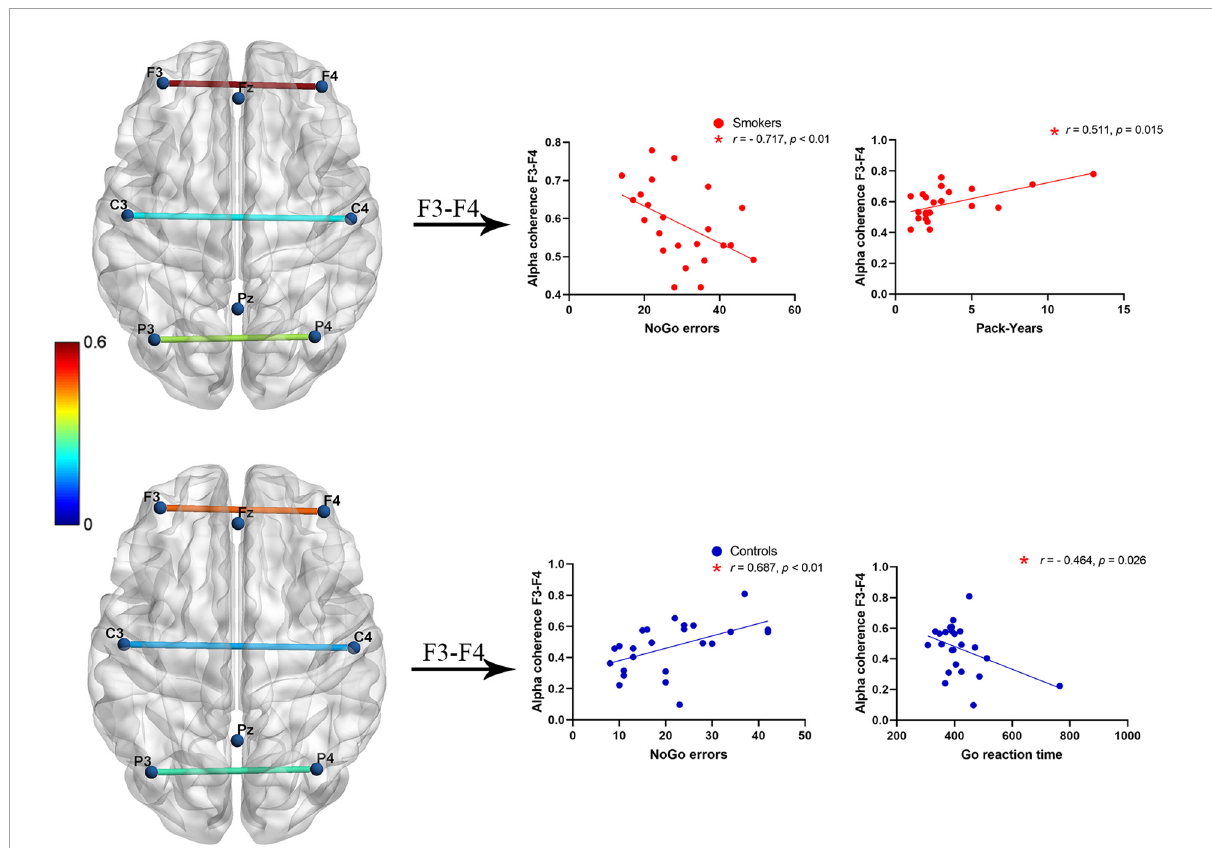
FIGURE2 A negative correlation between alpha coherence at F3–F4 electrode pairs and NoGo error numbers was found in young smokers ( p < 0.01), whereas a positive correlation between alpha coherence at F3–F4 electrode pairs and NoGo error numbers was found in healthy controls ( p < 0.01). Inverse patterns of correlations between alpha coherence at F3–F4 electrodes and Go reaction time ( p < 0.05). Positive correlations between Pack-Years and F3–F4 alpha coherence in young smokers ( p < 0.05).